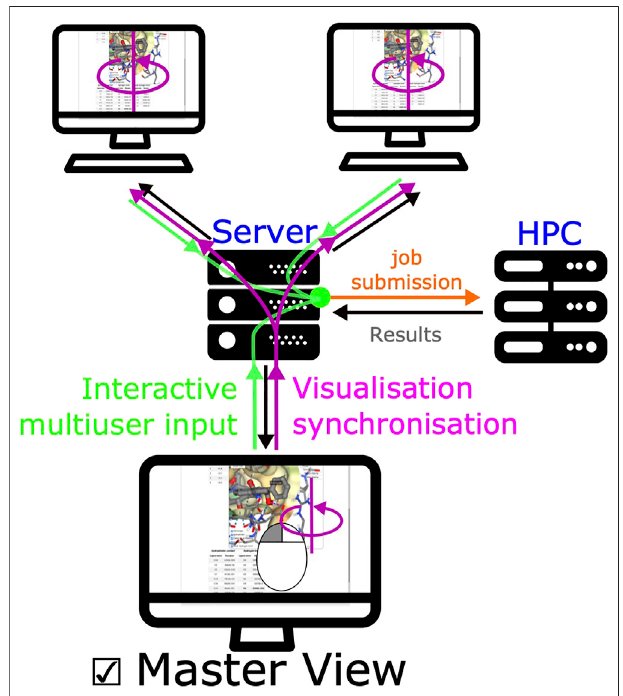
FIGURE 5 | Synchronized view mechanism. The synchronized view mechanismusestheseamlessfeatureforcommunicationbetweenserverand client. Once a user ticks the master view button, its web browser will send the NGL stage ’ s camera orientation and visualization options to the server via seamless, other clients ’ web browser will then update molecular visualization options. Any modi fi cation of input/output (ligand, receptor, or docking results) will be updated on all